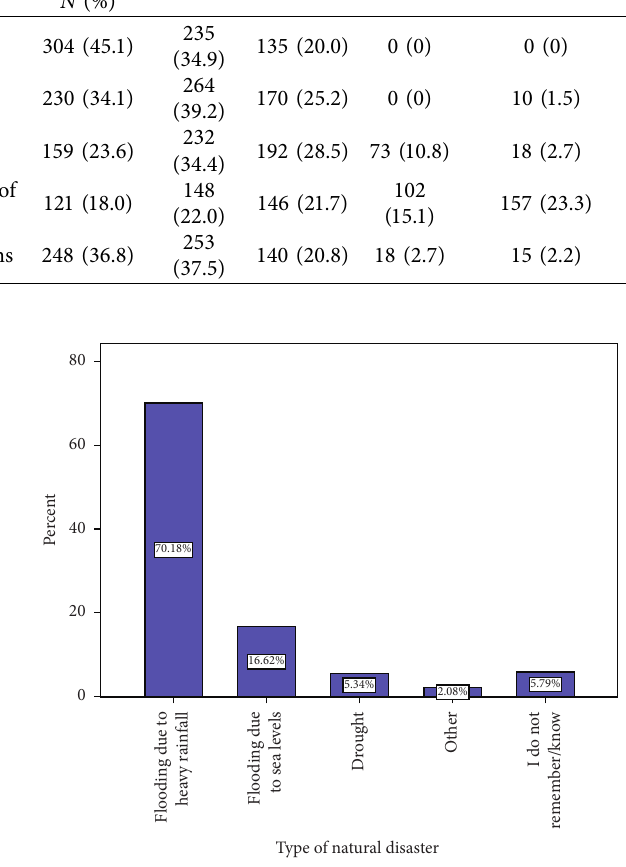
Figure 2: Type of natural disasters encountered by